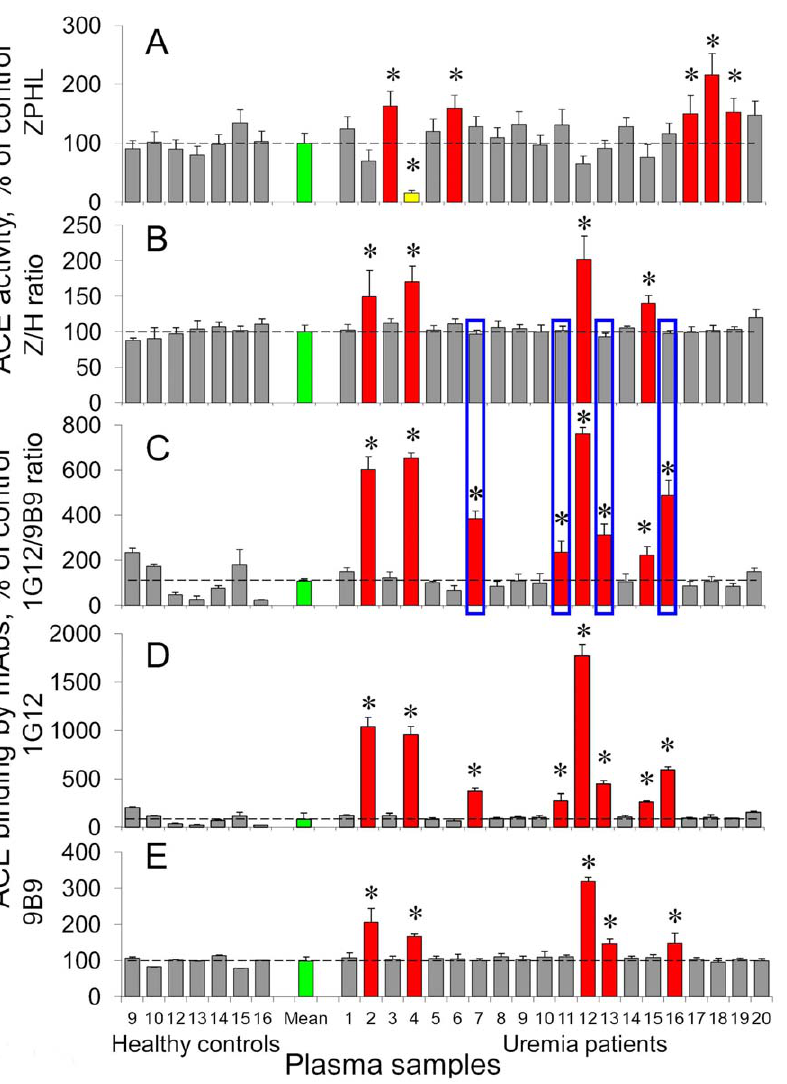
Figure 3. Blood ACE phenotyping in uremia. A . ACE activity in the citrated plasma (diluted 5-fold) of patients with uremia (versus that of healthy volunteers) was determined spectrofluorometrically using 20 m l of diluted plasma with 100 m l of ACE substrate ZPHL at 1 hour of incubation with substrate. B. The ratio of the rates of the hydrolysis of two substrates (ZPHL/HHL ratio) for ACE from the blood of patients with uremia and from the blood of healthy persons. C-E . ACE activity precipitated by different mAbs from citrated plasma of uremic patients (versus that from plasma of healthy donors: E - by mAb 9B9; D - by mAb 1G12 and C – their ratio for each plasma sample. Results are shown as mean 6 SD from 3 to 10 independent experiments, each in duplicates or triplicates. The red color of the columns shows plasma of those patients whose blood parameter (ACE activity, Z/H ratio, 1G12/9B9 ratio/mAb 9B9 or 1G12 binding) was significantly higher (and yellow bar-significantly lower) than mean value for healthy donors. The green bars shows mean values for healthy controls. Boxes show those patients which have increased 1G12/9B9 ratio while normal ZPHL/HHL ratio. All other terms and conditions are as in Fig. 1. * - p , 0.05 in comparison with mean value for healthy controls.